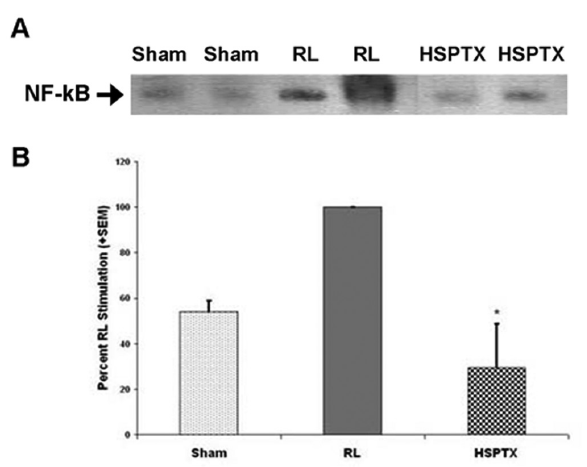
Figure 3 - NF- κ B-DNA Binding Activity after Hemorrhagic Shock and Resuscitation. A, Representative EMSA illustrating NF- κ B binding to DNA at 4 hours after post-shock resuscitation. The image displays two representa- tive animals from each experimental group. B, Histogram demonstrating the marked upregulation of NF- κ B-DNA binding activity associated with RL treat- ment. The graph presents changes in mean pixel density for n = 5-7 animals per group. HSPTX treatment attenuated this response by 70% and resulted in binding levels similar to those detected in the sham group. *, p = 0.01 vs. RL.